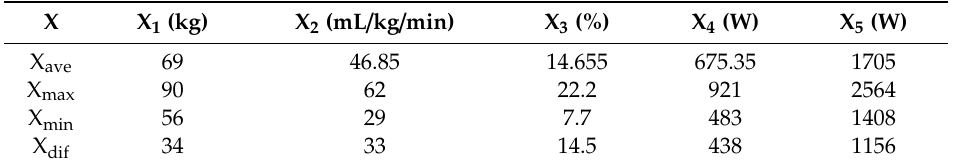
Table 1. The average value (X ave ), maximum value (X max ), minimum value (X min ) and the di ff erence between the maximum and minimum values (X dif ) of predictive variables X.